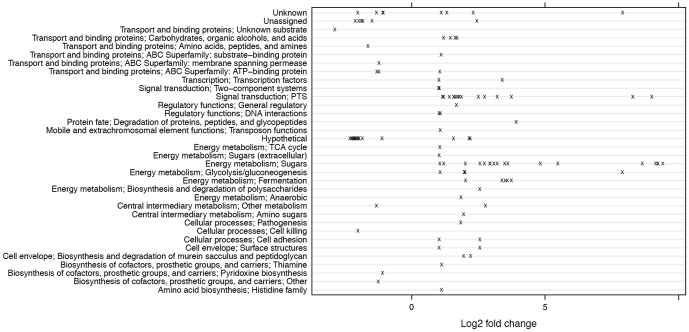
Distribution of functional classes of differentially expressed genes in UA159 growing in TV-glucose and TV-galactose.The x-axis represents the log2 values of the fold of change in expression (galactose/glucose).